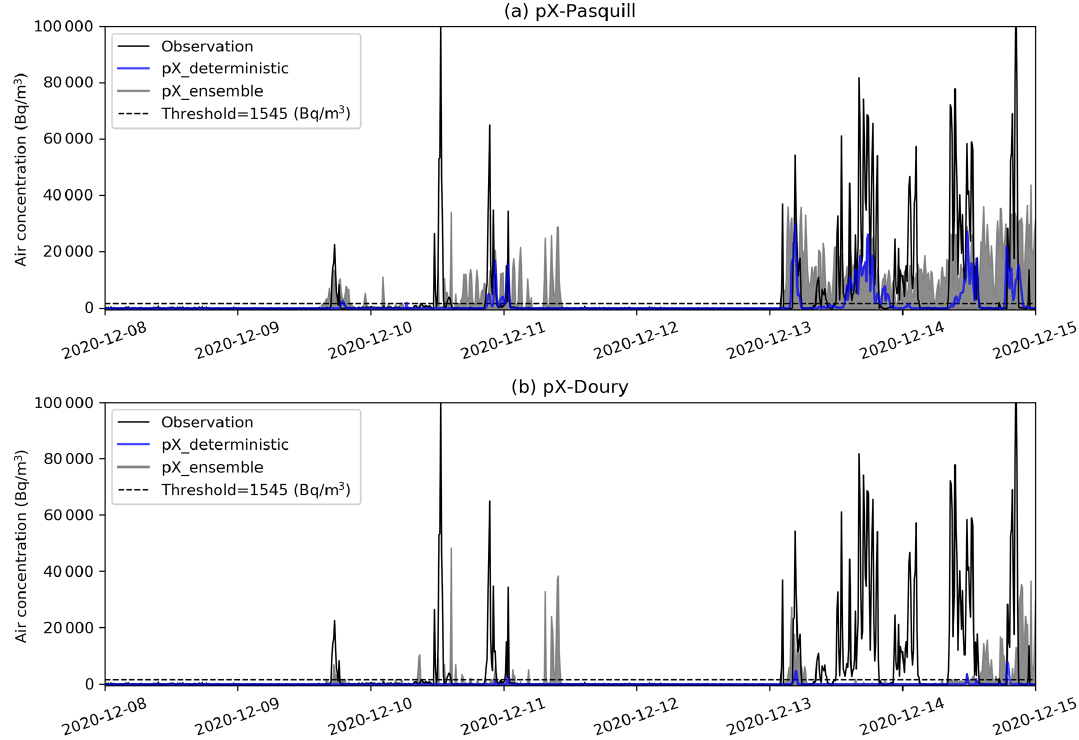
Figure 7. pX–Pasquill (a) and pX–Doury (b) ensemble and deterministic simulations of 85 Kr air concentration compared to the observation in the first aggregated period (Table 5), at the PTILH station. The horizontal dashed line shows the air concentration threshold (1545Bqm − 3 ) above which peaks are